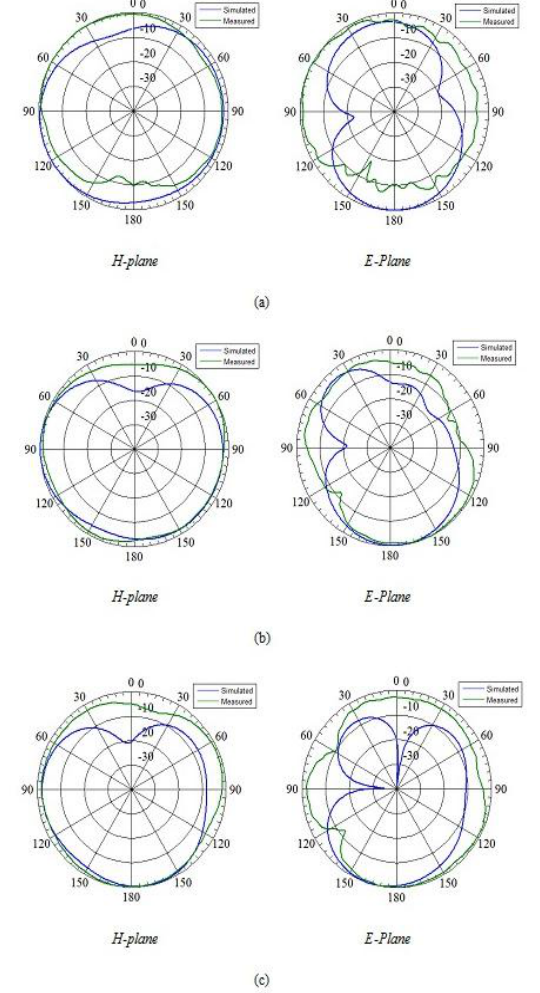
Fig. 14 : Radiation pattern of the combined antenna at (a)5 GHz (b)7 GHz (c)9 GHz.